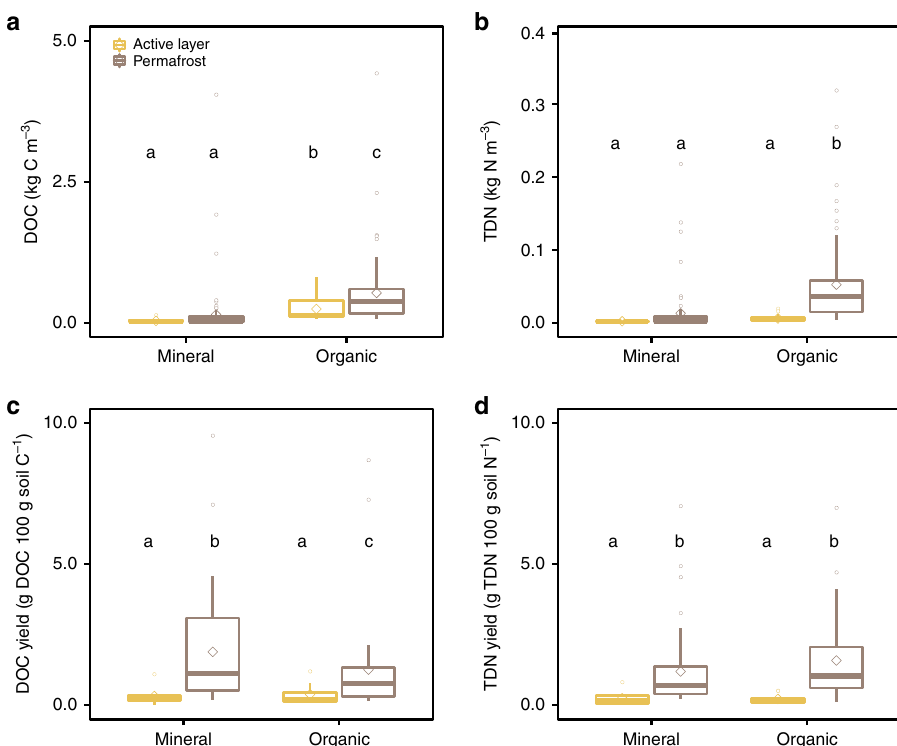
Fig. 1 Dissolved organic carbon and total dissolved nitrogen pools and yields in the active layer and permafrost. Samples are grouped by layer type with the following classi fi cation: organic layers (soil C ≥ 12%) and mineral layers (soil C < 12%). Letters indicate signi fi cant differences between thermal layers and soil types indicated by Mann-Whitney U test. The box plots summarize the distribution of a the amounts of dissolved organic carbon (DOC, kg C m − 3 ) and b total dissolved nitrogen (TDN, kg N m − 3 ) and the c water extractable yields in DOC (g DOC 100 g soil C − 1 ) and d TDN (g TDN 100 g soil N − 1 ) for each layer type and in the active layer and underlying permafrost (calculated from multiple 25 cm increments). In each box plot, the diamond represents the mean, the horizontal line represents the median, the end of the box the 25 th and 75 th percentiles, and the lines extending from the box are 1.5 interquartile ranges from the median. Data points outside of the 1.5 interquartile ranges are represented as